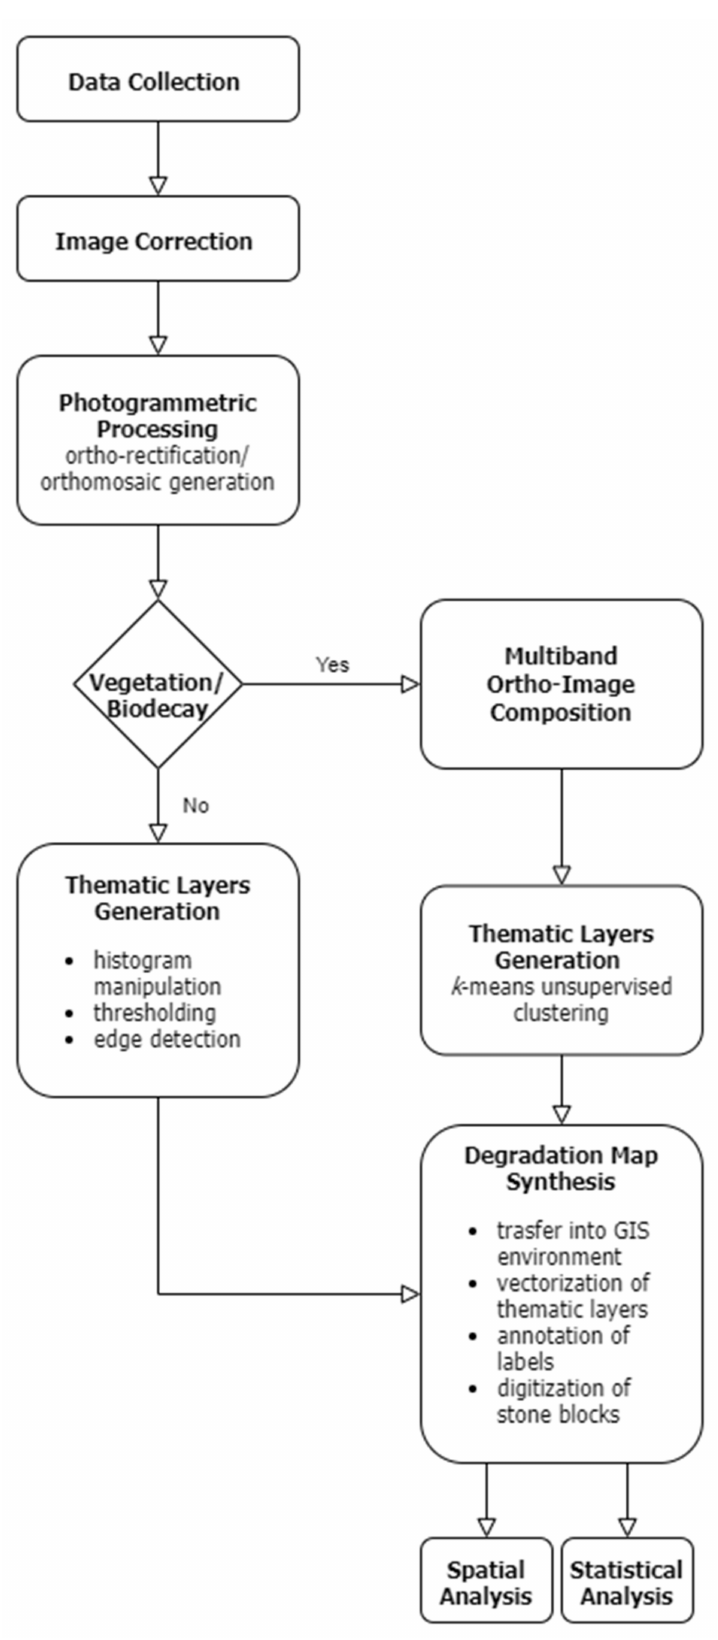
Figure 1. Schematic representation of the methodological